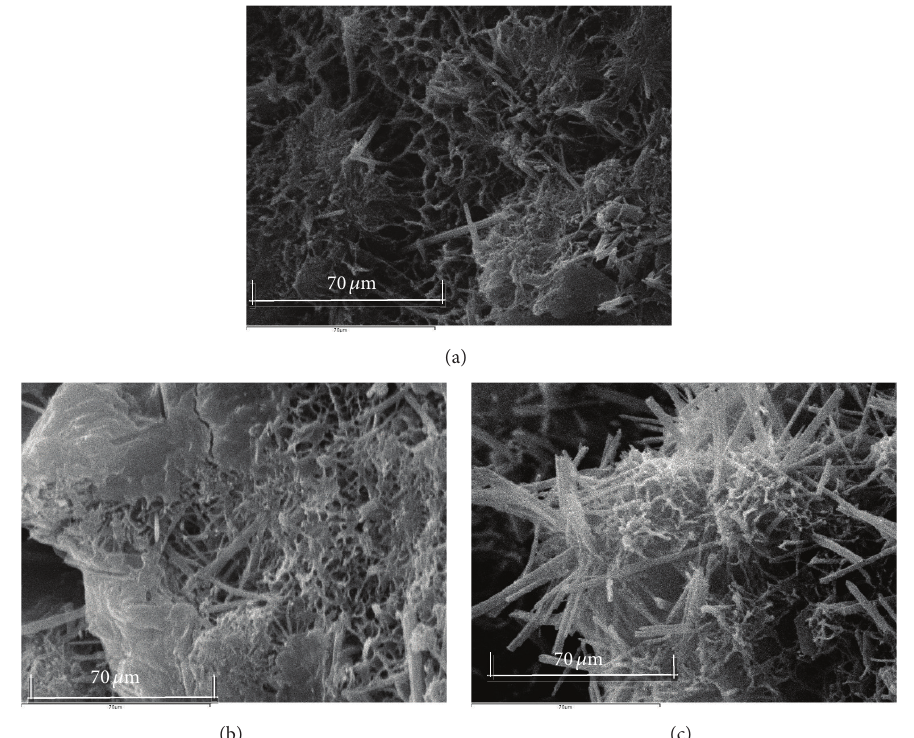
Figure 4: SEM photos of hydration products with different smelting slag content: (a) 55%; (b) 60%; (c) 65%.